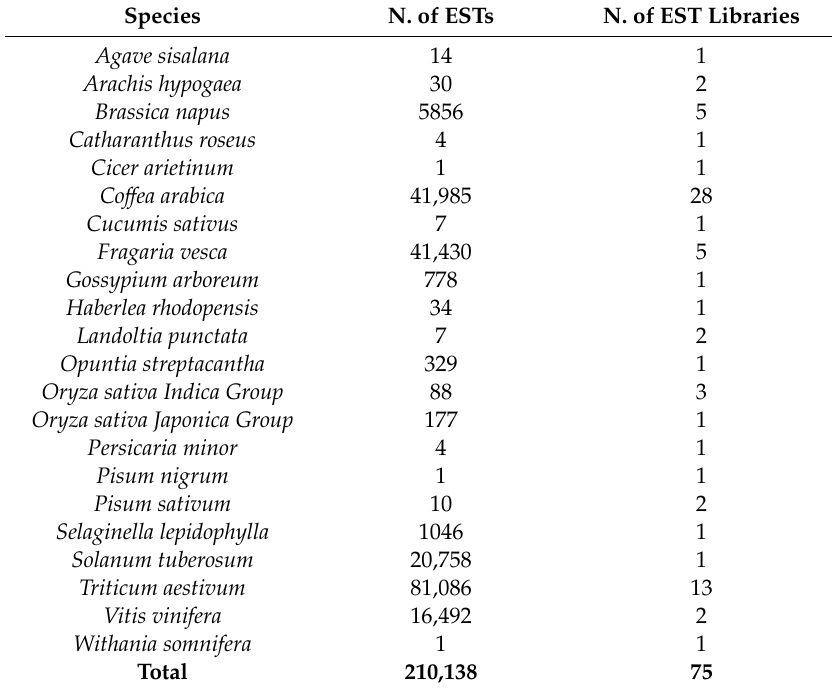
Figure 1. “Abiotic stress”-related expressed sequence tags per each plant species available in dbEST database. Table 4. “Abiotic stress”-related expressed sequence tag (EST) libraries per each plant species available in